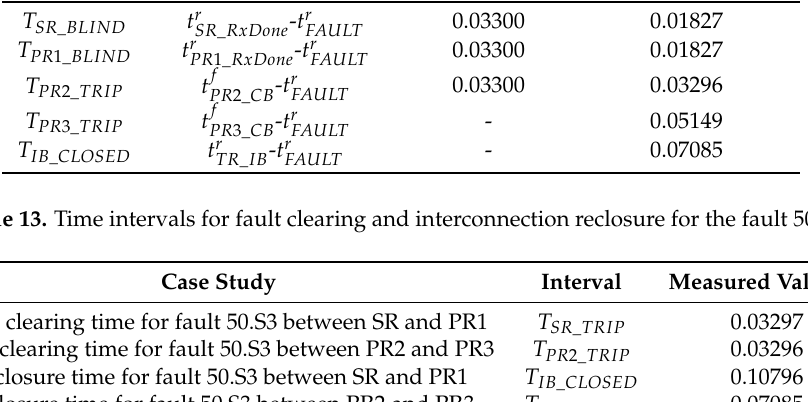
Table 12. Estimated time intervals during the fault 50.S3 between PR2 and PR3.